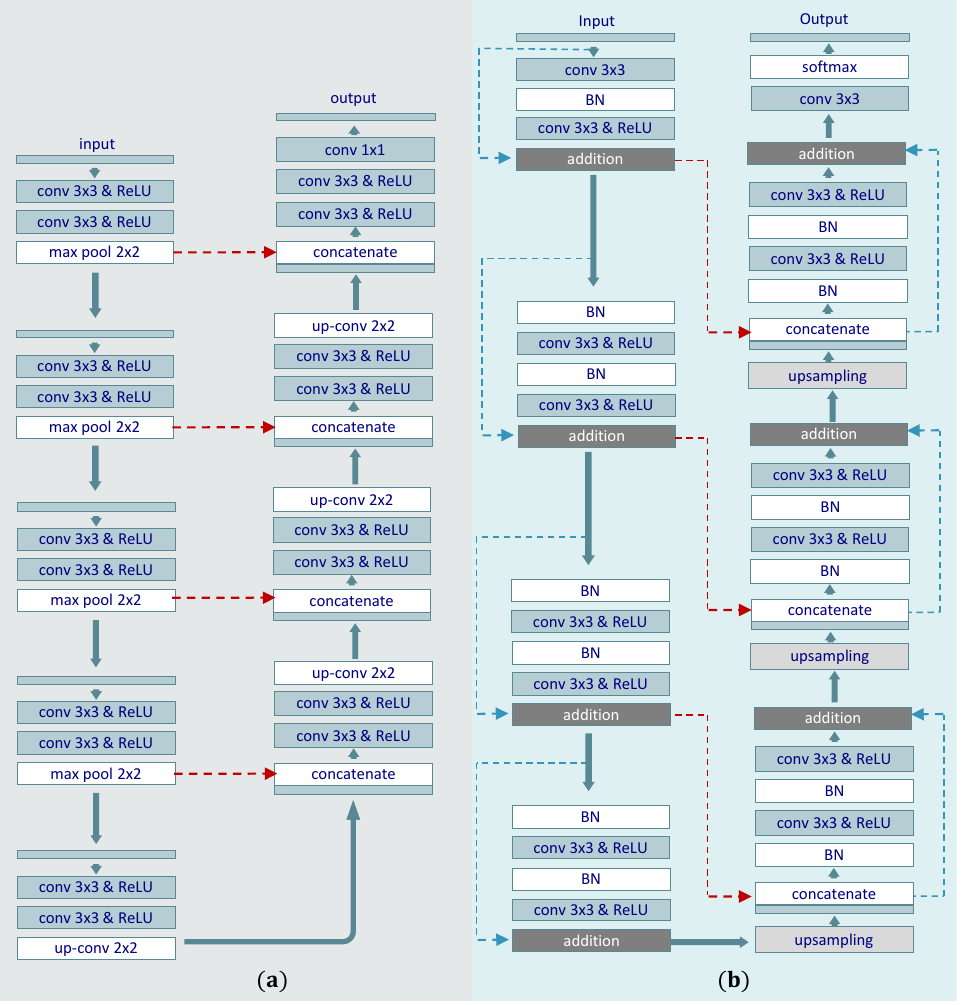
Figure 3. Illustration of the architecture of: ( a ) a typical convolutional process in a U-Net; and ( b ) a residual U-Net with an identity mapping. The dotted red and blue refer to the skip connections between low levels and high levels of the network and identity mapping,